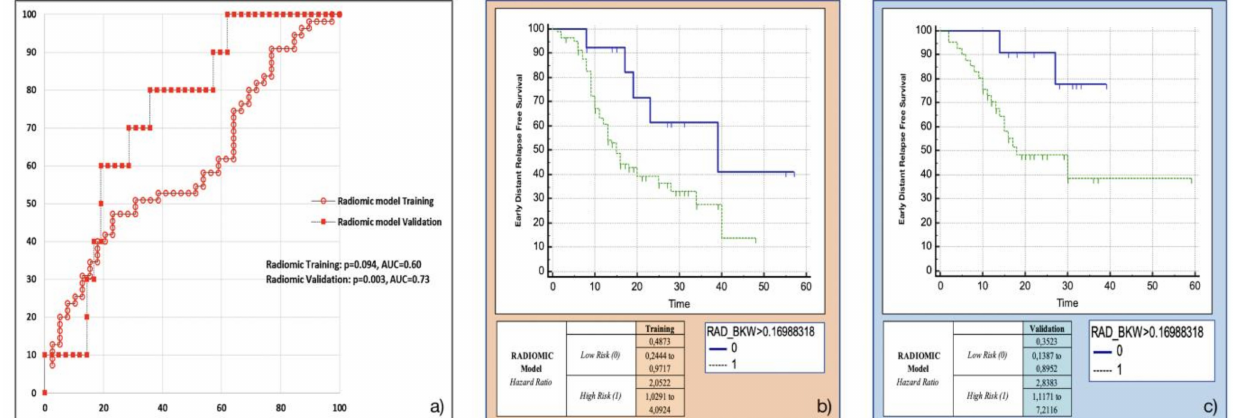
Figure 4. Radiomic model overall performance in terms of ( a ) area under the ROC curve (AUC) for both training (red empty circles) and validation (red filled squares) cohorts, and outcome prediction in terms of Kaplan Meier curve separation between low and high risk patients according to the computed prognostic index in both training ( b ) and validation ( c ) cohorts.